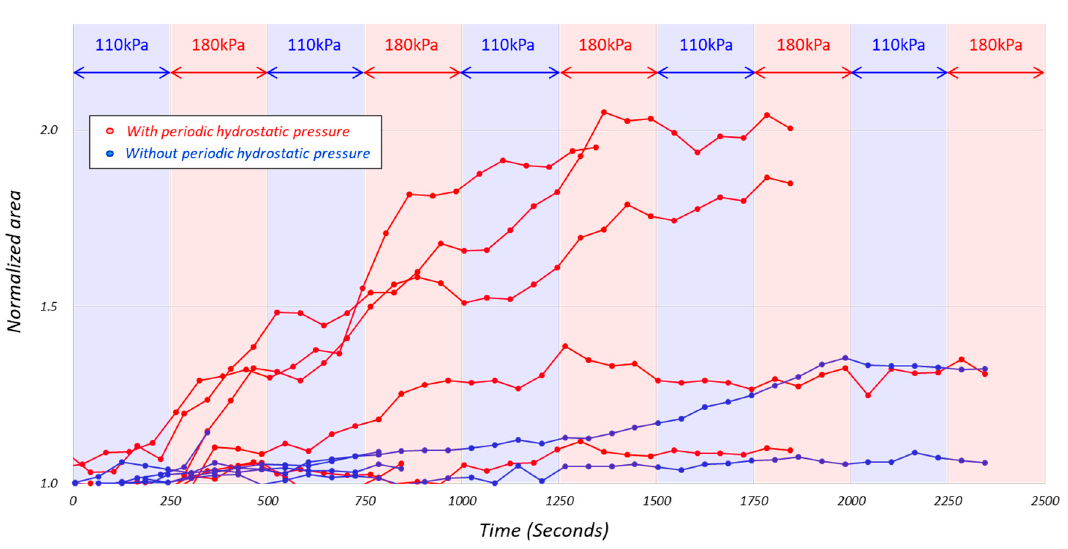
Figure 8. The normalized projected cell area S( t ) where the origin of the horizontal axis is the time corresponding to (c) in Figure 6, more specifically when the pressure is switched from 180 kPa to 110 kPa in the nearest time around (c) in Figure 6, and normalized for each of the six original data shown in Figure 5.